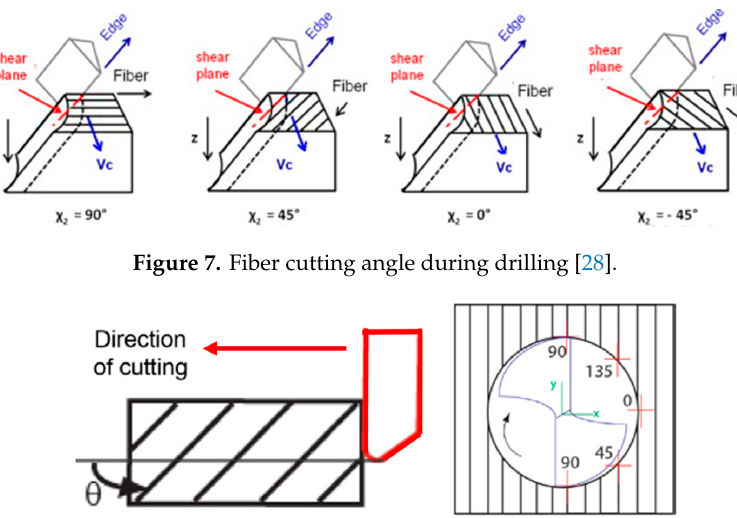
Figure 8. Variation of fiber cutting angle during drilling [29].